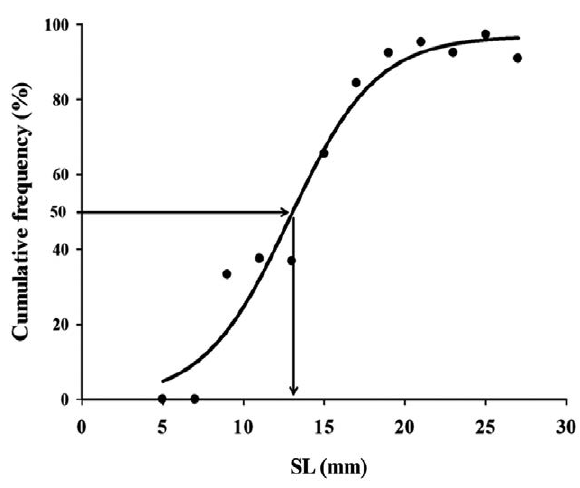
Fig. 7. – Logistic curve indicating the average size at first maturity in Donax striatus